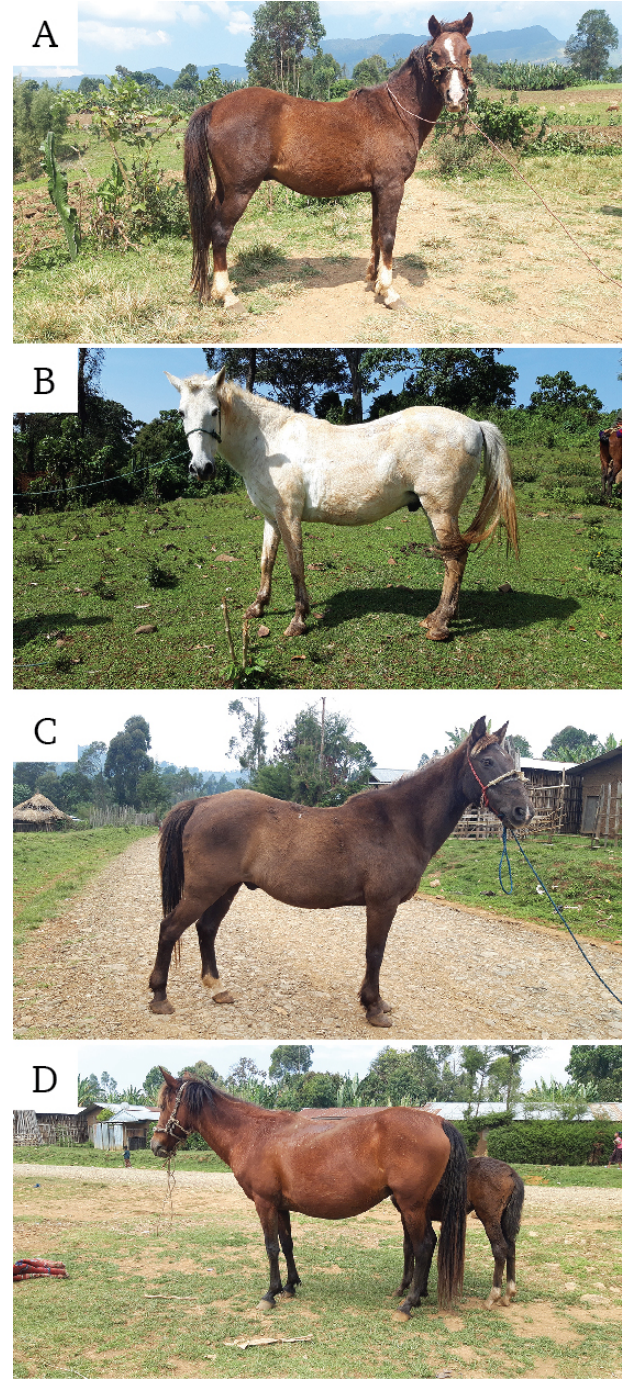
Figure 3. A, Telo stallion; B, Masha stallion; C, Gesha stallion; D, Gesha mare. Photo: Amine Mustefa, EBI can be categorized as typical saddle horses. This is in